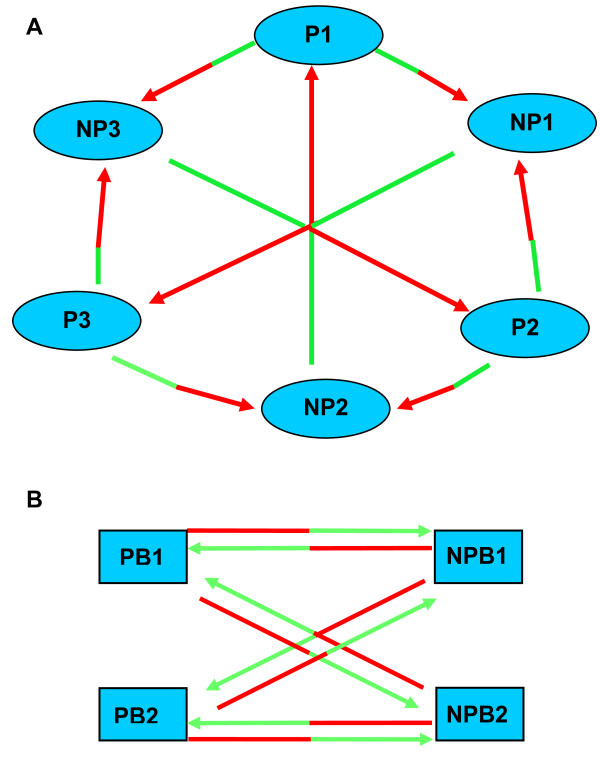
Hybridisation designs for testes and brain microarray. (a) Testes sample pools were hybridised using a loop design. Three precocious pools (P1-P3) each of four individuals were hybridised to three non-precocious pools (NP1-NP3) each of ten individuals. Each sample pool at the tail of the arrow (green) was Cy3-labelled and that at the arrowhead (red) was Cy5-labelled. Each pool was hybridised three times and at least once with each of the Cy5 or Cy3 dyes to maintain dye balance. Analysis was with LIMMA software. (b) Brain samples were hybridised directly using pools of five individuals. Pool labelling was as detailed above. Two separate pools of precocious brains (PB1 and PB2) were each compared directly to two separate pools of non-precocious brains (NPB1 and NPB2). All hybridisations include dye swaps. Analysis was with LIMMA software.